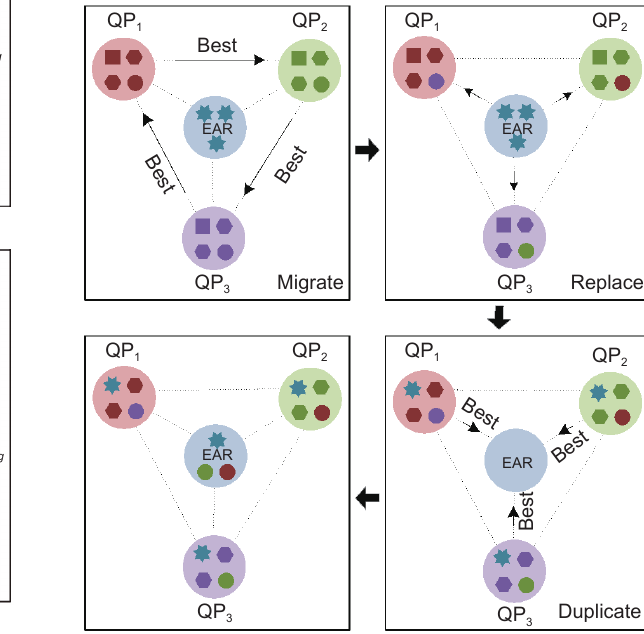
Fig. 3 Simplex operator. Fig. 4 Example of knowledge